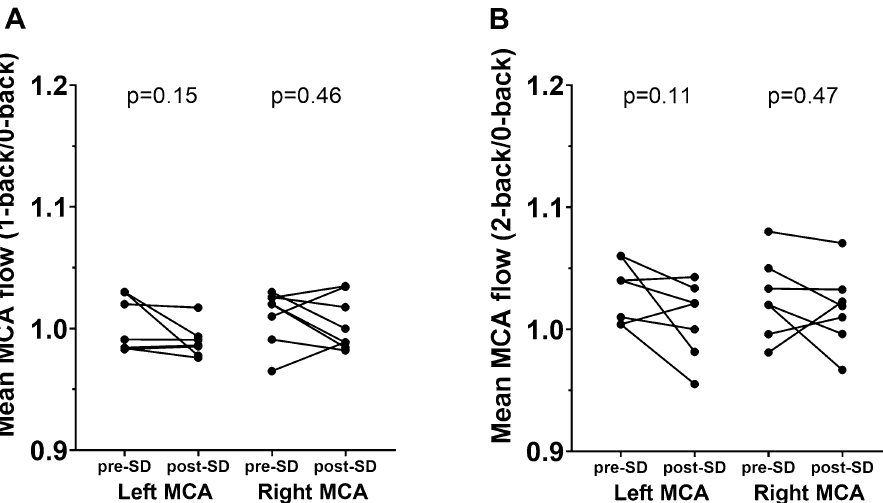
Figure 4. The effect of sleep deprivation on NVC-related hemodynamic responses measured in the middle cerebral artery using transcranial Doppler sonography. Hemodynamic NVC responses were measured in both middle cerebral arteries (MCA) in response to cognitive n -back test using transcranial Doppler sonography. NVC responses were evaluated during 1-back and 2-back tasks, normalized to preceding 0-back task. We observed a non-significant trend for a decrease in NVC in the left MCA during both 1-back (panel A) and 2-back tasks (panel B). Wilcoxon signed-rank test was used for comparisons. p < 0.05 was considered